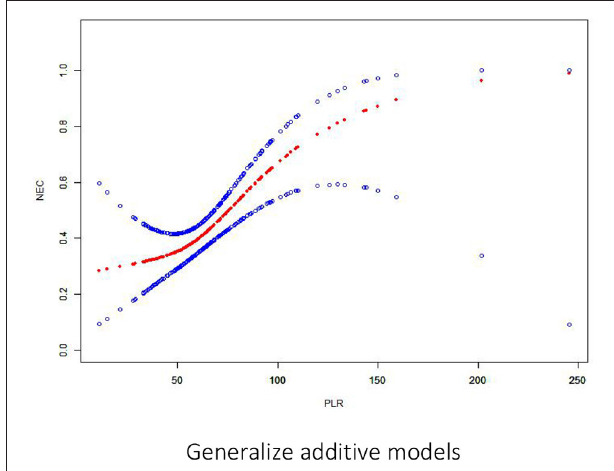
FIGURE 2 | Association between PLR and NEC. There is a threshold and non-linear association between PLR and NEC ( p < 0.05) in the generalized additive model (GAM). The smooth curve fit between variables is represented by a solid red line. The 95% confidence interval from the fit is represented by blue bands.